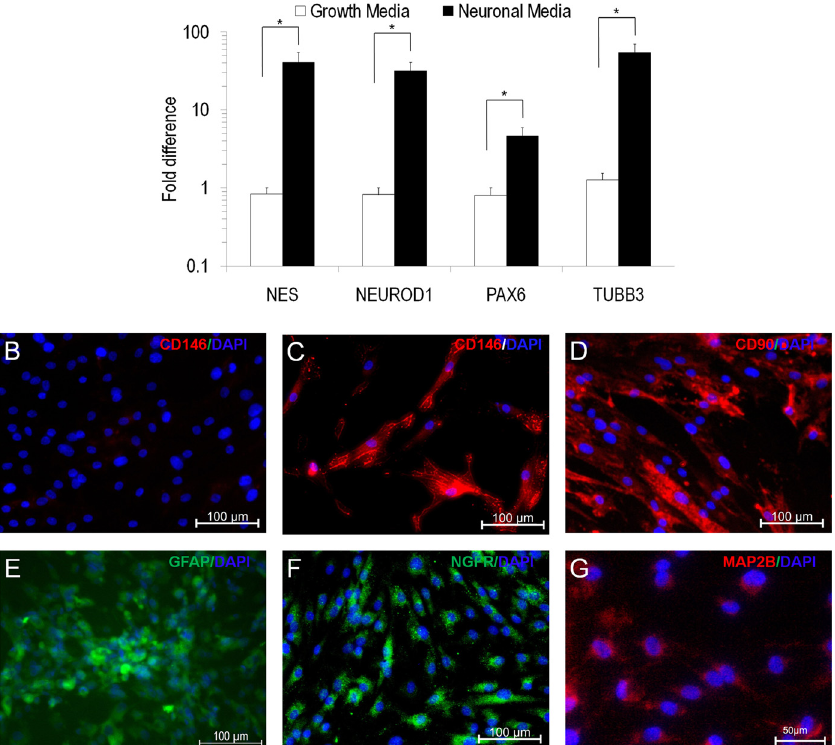
Fig 4. Neuronal differentiation of EOM-MSC. (A) Real-time PCR analysis of neuronal specific genes NES, NEUROD1, PAX6 and TUBB3 in EOM-MSC cultured in growth media and neuronal differentiation media for 14 days. The expression levels of the genes were normalized to GAPDH expression levels in the respective samples. Values are Mean ± SEM, n = 5, * p < 0.05. Immunoflurescence analysis of neuronal differentiated EOM-MSC showing downregulation of CD146 in cells cultured in (B) neuronal media compared to cells grown in (C) normal growth media. (D) CD90 expression was unaffected in EOM-MSC cultured in neuronal media. Neuronal differentiated cells exhibited upregulation of neuronal lineage markers (E) GFAP, (F) NGFR and (G) MAP2B. CD90, CD146 and GFAP staining were performed 9 – 10 days after the addition of neuronal induction media whereas NGFR and MAP2B staining were performed after 21 days of neuronal induction. Representative microscopic images are